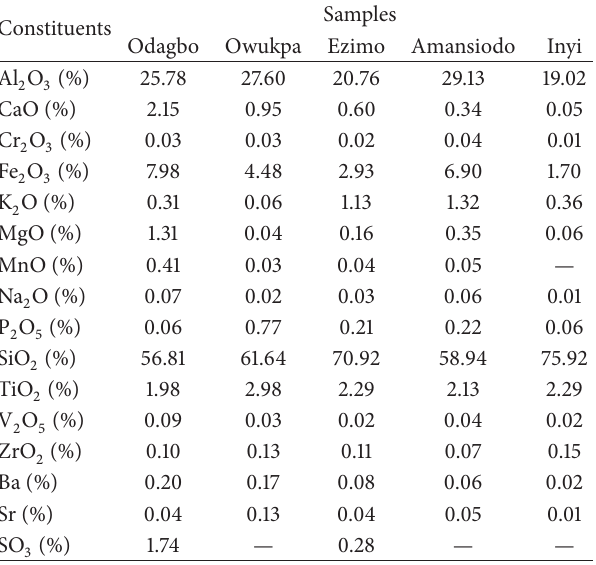
Table 6: Results of ash fusion temperature test (in reducing atmosphere) of the five coal samples.